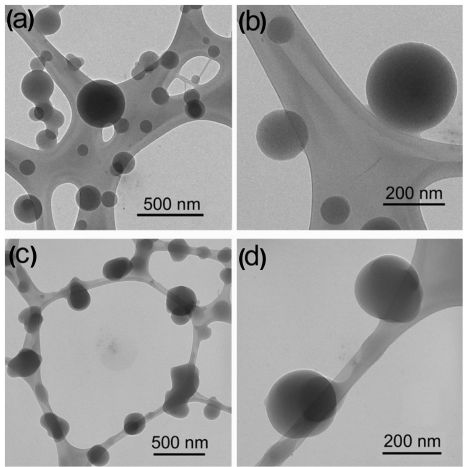
Figure 2. TEM images of tar balls generated from the aqueous (a, b) (sample 16-d2) and oily (c, d) phase of tar obtained from dry distillation of